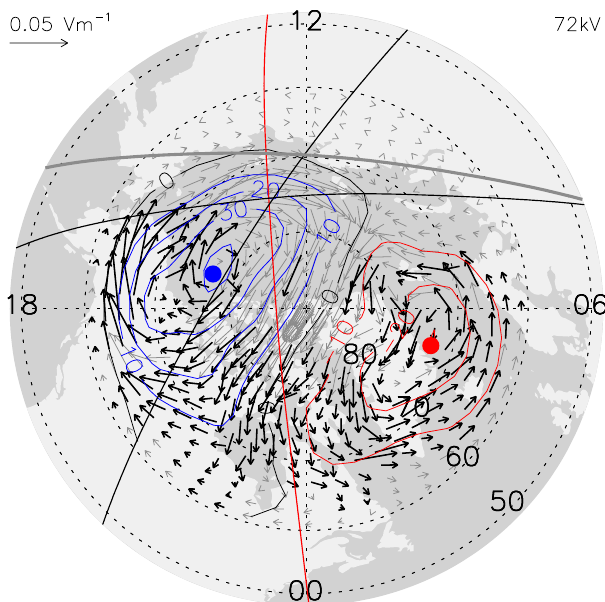
Fig. 7. Electric field vectors (rotated 90 ◦ counter clockwise) cal- culated from SuperDARN data averaged over 03:30–04:30 UT, 1 November, 2001. The electric potential contours, DMSP and Oer- sted tracks and the sunlight terminator are overlayed. The extremes in potential are located at the blue (-ve) and red (+ve) dots. The electric field vectors are bold at locations where radar returns were